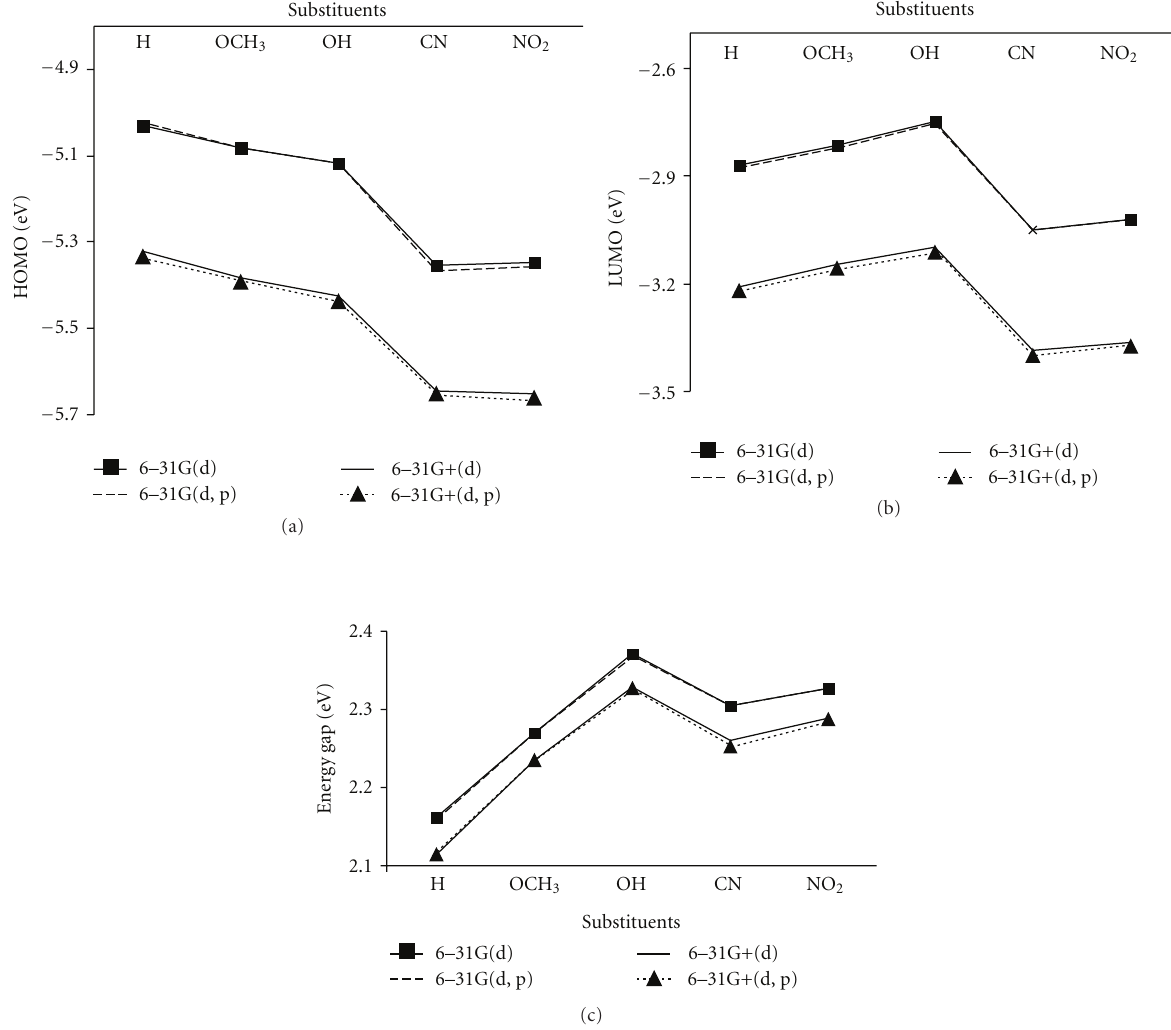
Figure 4: (a) HOMO, (b) LUMO, and (c) energy gap of the PTP compound (where R = R (cid:2) = –H), and its derivatives (where R = R (cid:2) = –H, –OCH 3 , –OH, –CN, and –NO 2 ), calculated using the B3LYP method with di ff erent basis sets.